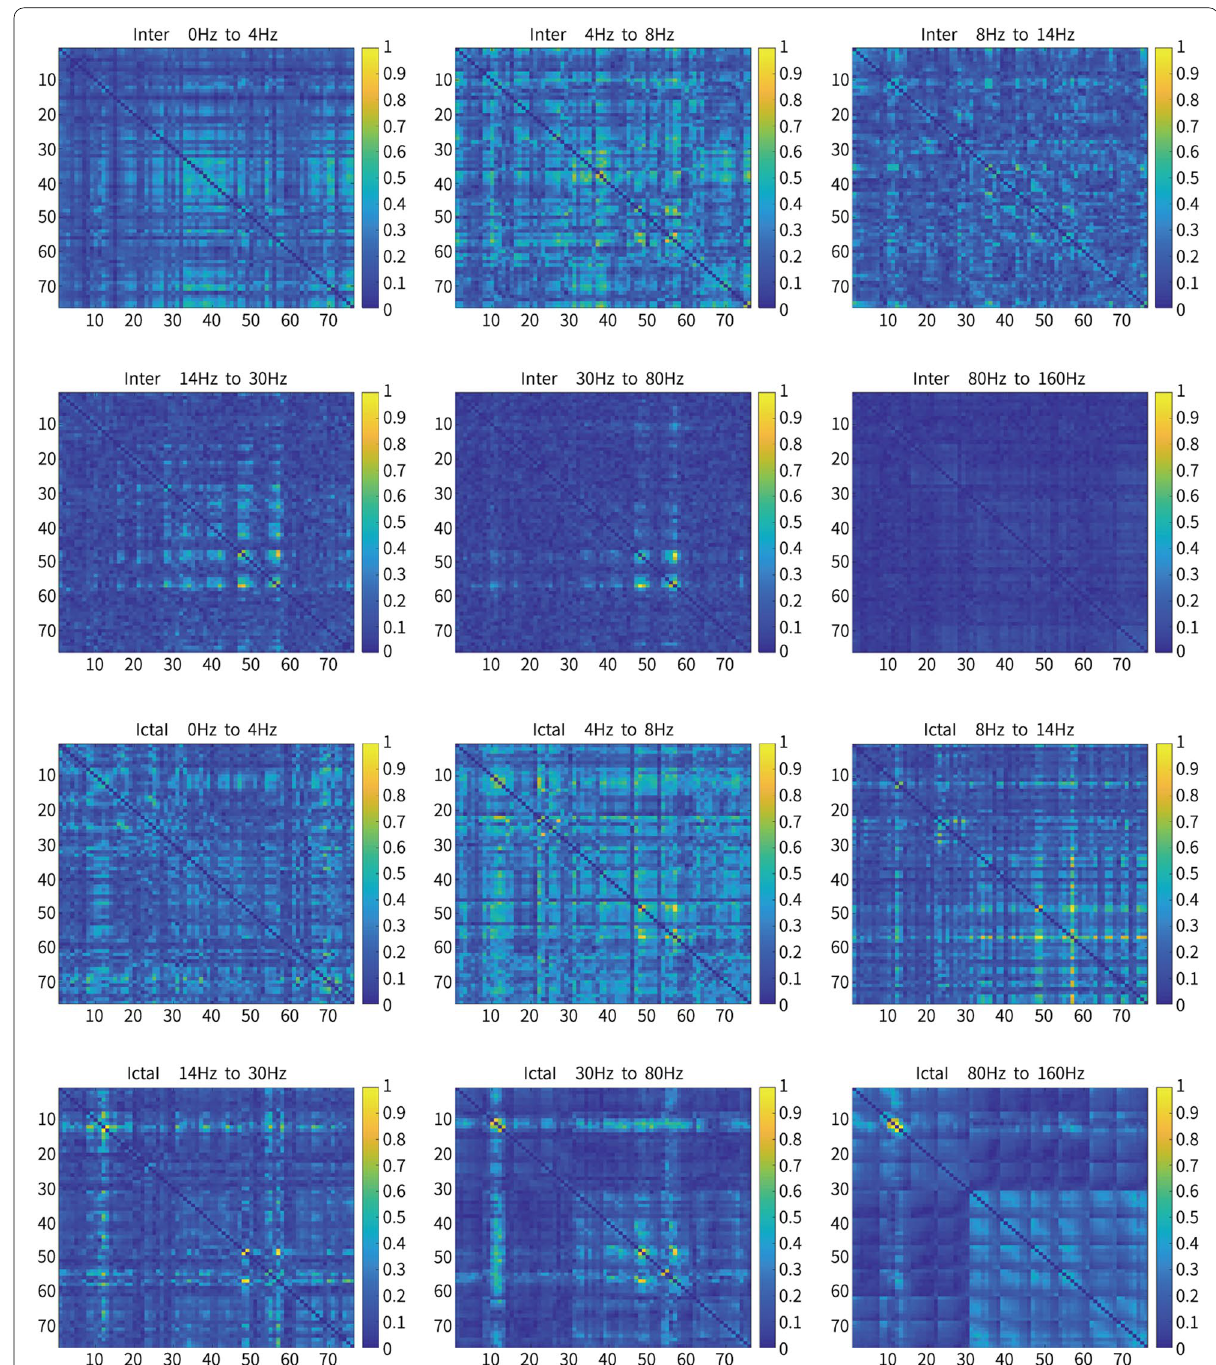
Fig. 4 Matrices of integrated synchronization index during the interictal and ictal periods for patient 1 (Channels 8, 17, 49, and 66 of the ECoG were omitted from analysis because of